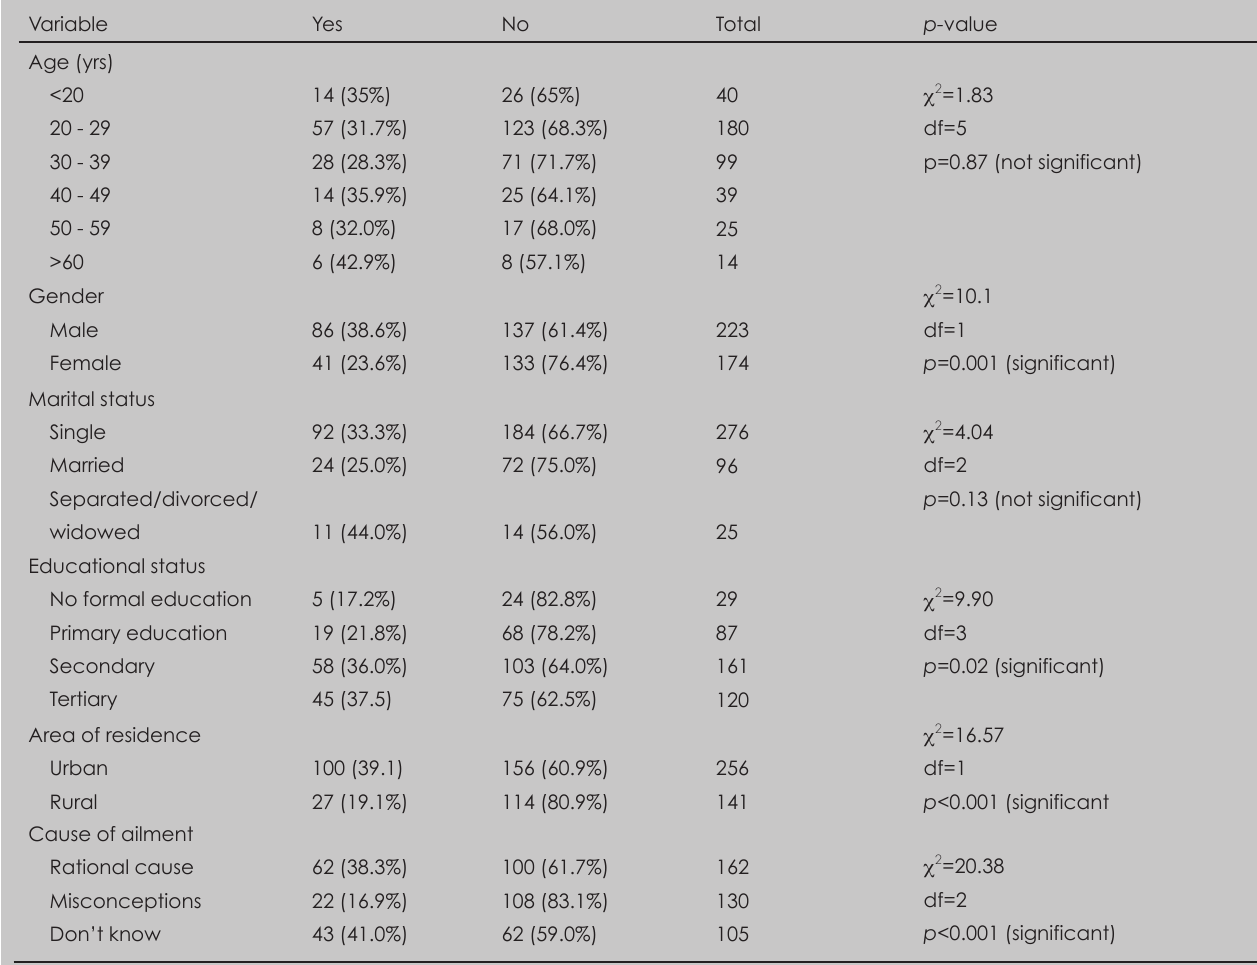
Table III. Relationship between socio-demographic characteristics of respondents and choice of psychiatric hospital as first place of